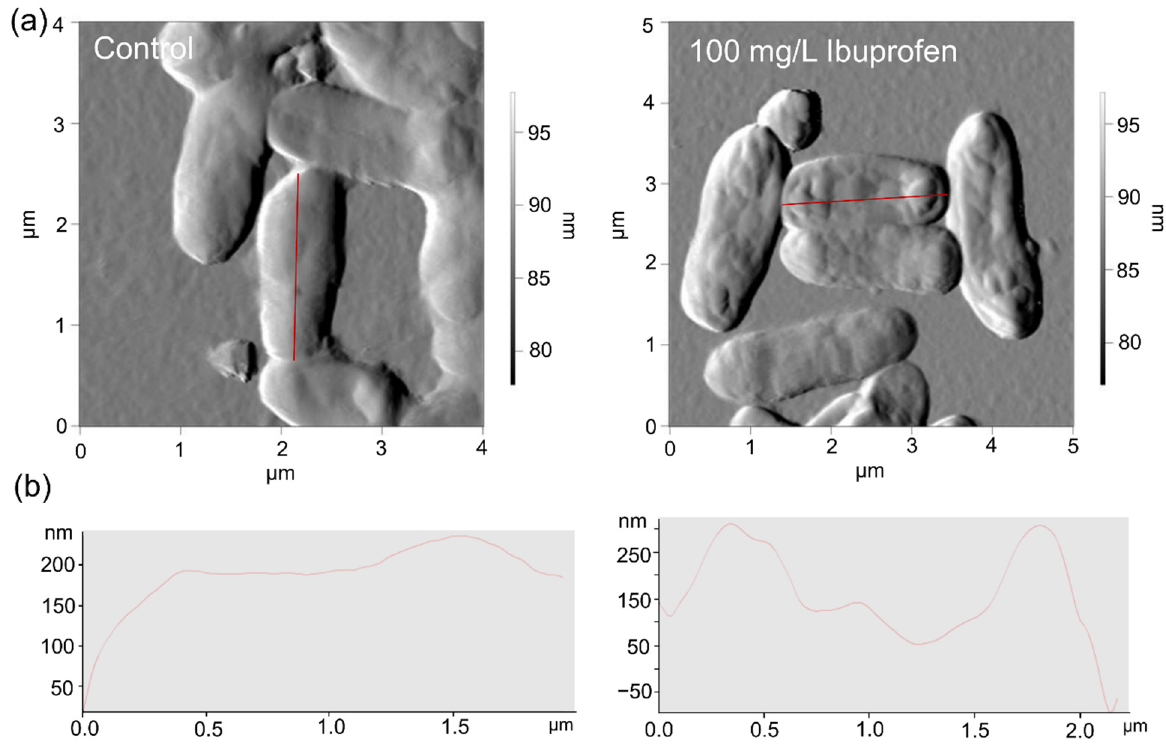
Figure 5. AFM ( a ) images and profiles ( b ) of R . cerastii IEGM 1278. Cells were grown for three days with 0.1 g/L glucose (control), or 0.1 g/L glucose and 100 mg/L ibuprofen.